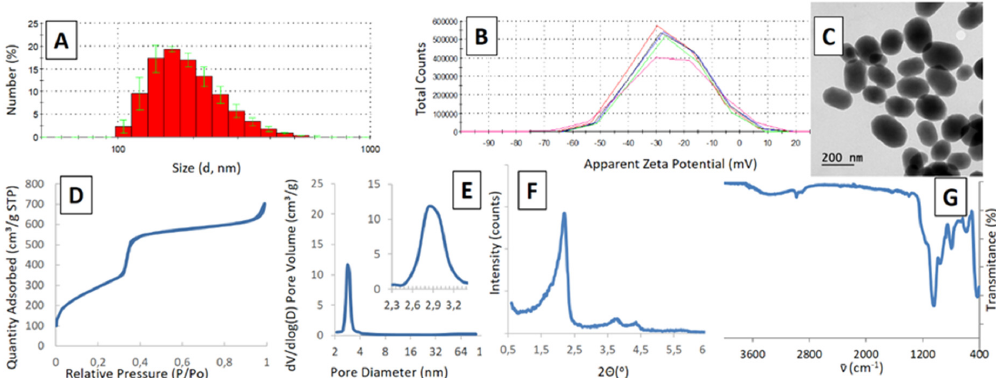
Figure 9. Characterization for scaled-up MCM-41 like MSNs Experimental conditions: 5 L jacketed cylindrical reactor with 4 L working volume with a Rushton turbine as overhead stirrer (650 rpm).